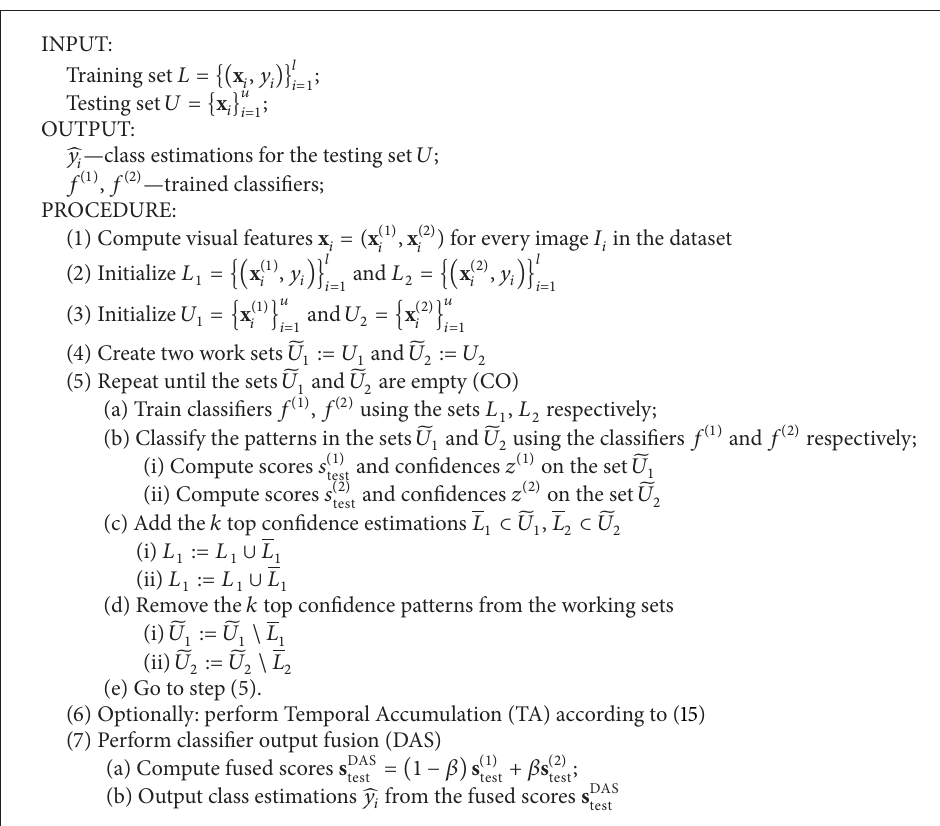
Algorithm 1: The CO-DAS and CO-TA-DAS